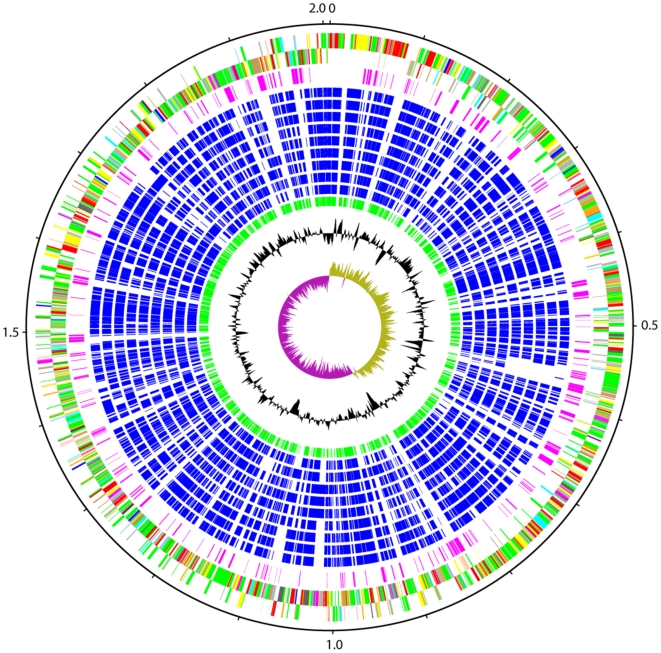
Schematic circular diagram of the S. suis P1/7 genome.Key for the circular diagram (outer to inner): scale (in Mb); annotated CDSs coloured according to predicted function are shown on a pair of concentric circles, representing both coding strands; Streptococcus suis orphan CDSs, purple; orthologue matches shared with the Streptococcal species, S. mutans UA159, S. gordonii Challis CH1, S. sanguinis SK36, S. pyogenes Manfredo, S. equi 4047, S. agalactiae NEM316, S. uberis 0140J, S. pneumoniae TIGR4, S. thermophilus CNRZ1066, blue; orthologue matches shared with Lactococcus lactis subsp. lactis, green; G+C% content plot; G+C deviation plot (>0% olive, <0% purple). Colour coding for P1/7 CDS functions: dark blue, pathogenicity/adaptation; black, energy metabolism; red, information transfer; dark green, surface associated; cyan, degradation of large molecules; magenta, degradation of small molecules; yellow, central/intermediary metabolism; pale green, unknown; pale blue, regulators; orange, conserved hypothetical; brown, pseudogenes; pink, phage and IS elements; grey, miscellaneous.